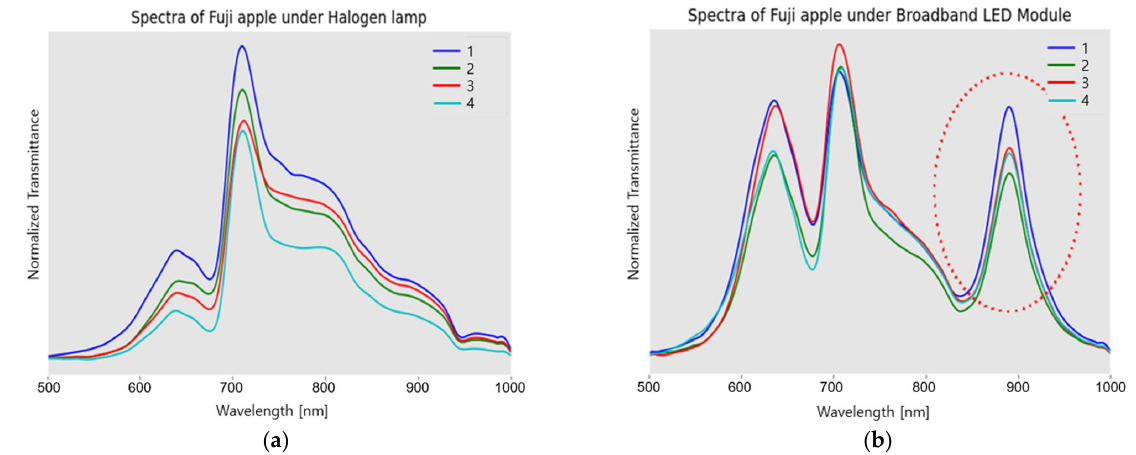
Figure 5. Spectral transmittance through a Fuji apple using the TH ‐ lamp, and the Vis + NIR LED module: Spectra transmitted by radiation of ( a ) the TH lamp at the four equatorial positions of a Fuji apple; ( b ) the Vis + NIR LED module, including the second order diffraction of 450 ‐ nm peaked ra ‐ diation from a blue LED device of SFH4776 and GW CSSRM2.EM; Numbers of 1–4 for the positional acquisition of one Fuji apple